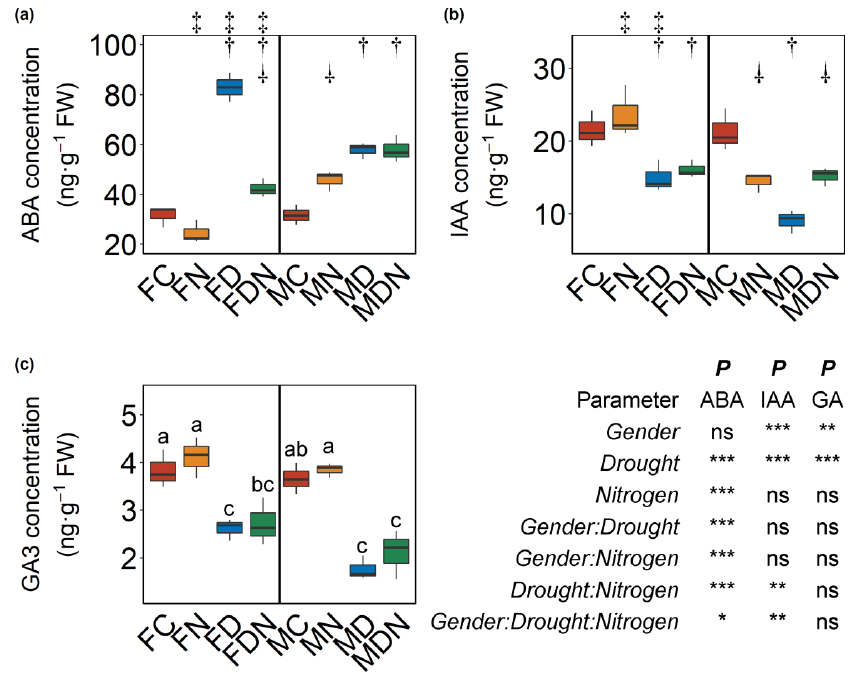
Figure 6. The endogenous hormones of leaves ( n = 3). ( a ) Foliar ABA; ( b ) foliar IAA; ( c ) foliar GA 3 . F, females; M, males; C, control; N, N deposition; D, drought; DN, drought and N deposition. The double dagger (‡) indicates simple effect of gender, the dagger (†) indicates simple effect of drought, and the inverted dagger ( ⸸ ) indicates simple effect of N deposition. Different letters among groups indicate significant differences (Tukey test, p < 0.05). Asterisks denote significant differences: ***, p < 0.001; **, p < 0.01; *, p < 0.05.